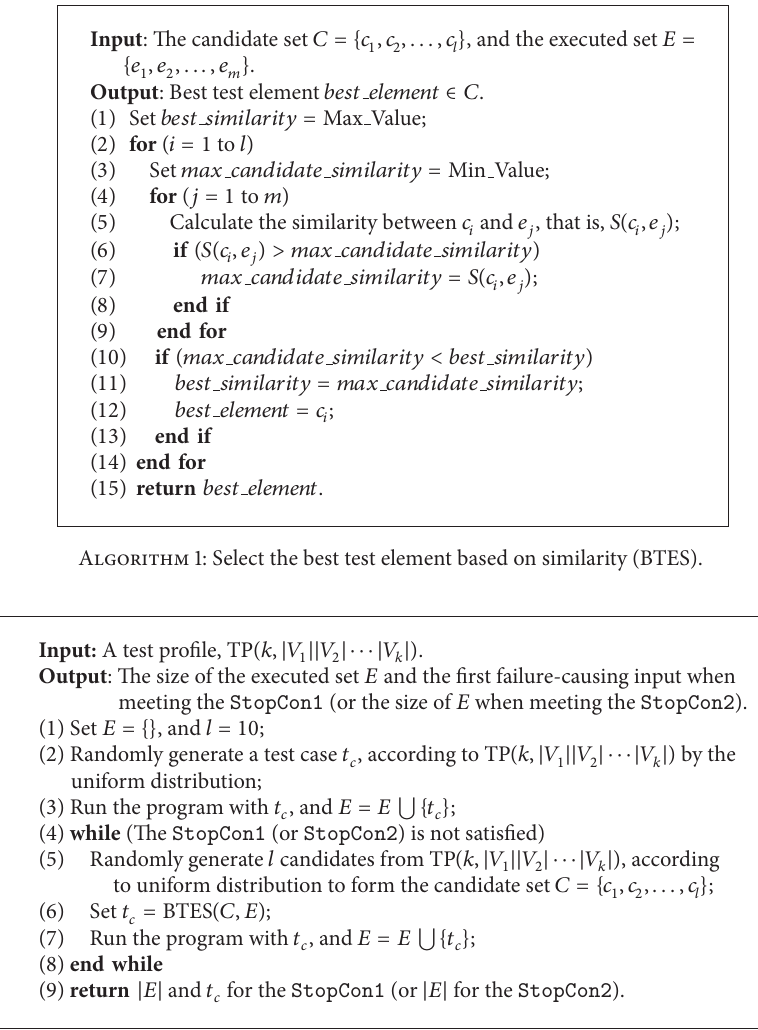
Algorithm 2: The algorithm of